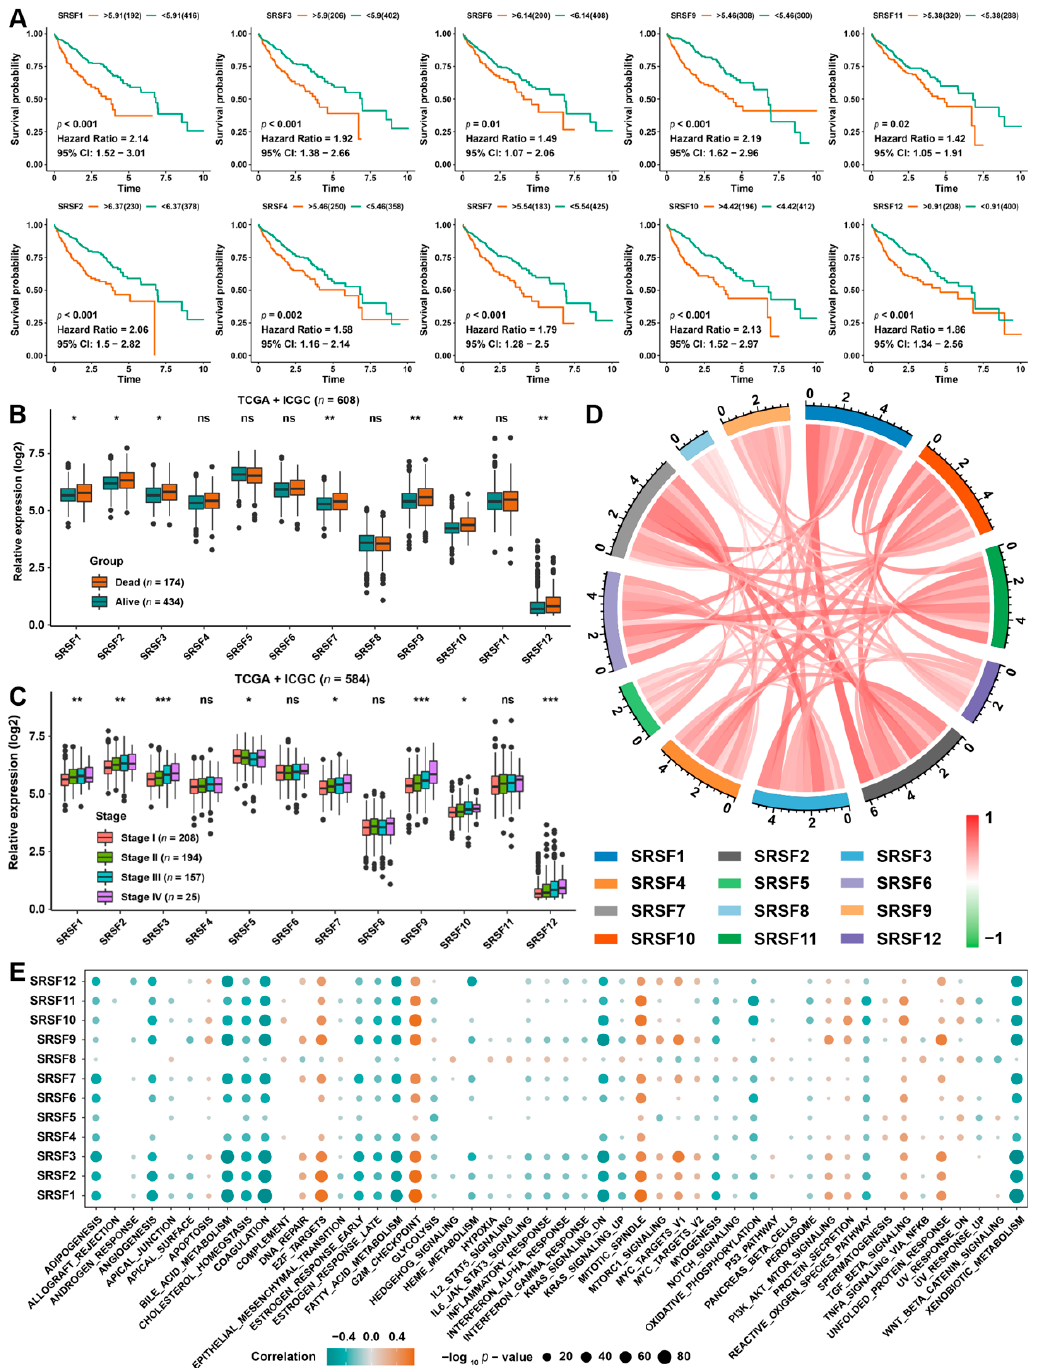
Figure 2. The prognostic analysis of SRSF family genes in HCC. ( A ) Kaplan–Meier curves of OS in the aggregated HCC cohort are stratified by the optimal cut-off value of the indicated SRSF genes. ( B ) The relative expression of 12 SRSF family genes based on the patient outcome in the aggregated HCC cohort. ( C ) The relative expression of 12 SRSF family genes based on tumor stage in the aggregated HCC cohort. ( D ) The interaction among SRSF family genes in HCC. The lines linking genes showed their interactions, and the thickness of lines showed the correlation strength. Positive correlations are marked with red lines, and negative correlations are marked with green lines. ( E ) KEGG signaling pathways associated with each SRSF family gene. The size of the circle represents the P value, with red representing a positive correlation and green representing a negative correlation. The asterisks represent the statistical p -value (* p < 0.05, ** p < 0.01 and *** p < 0.001. ns, no significance).